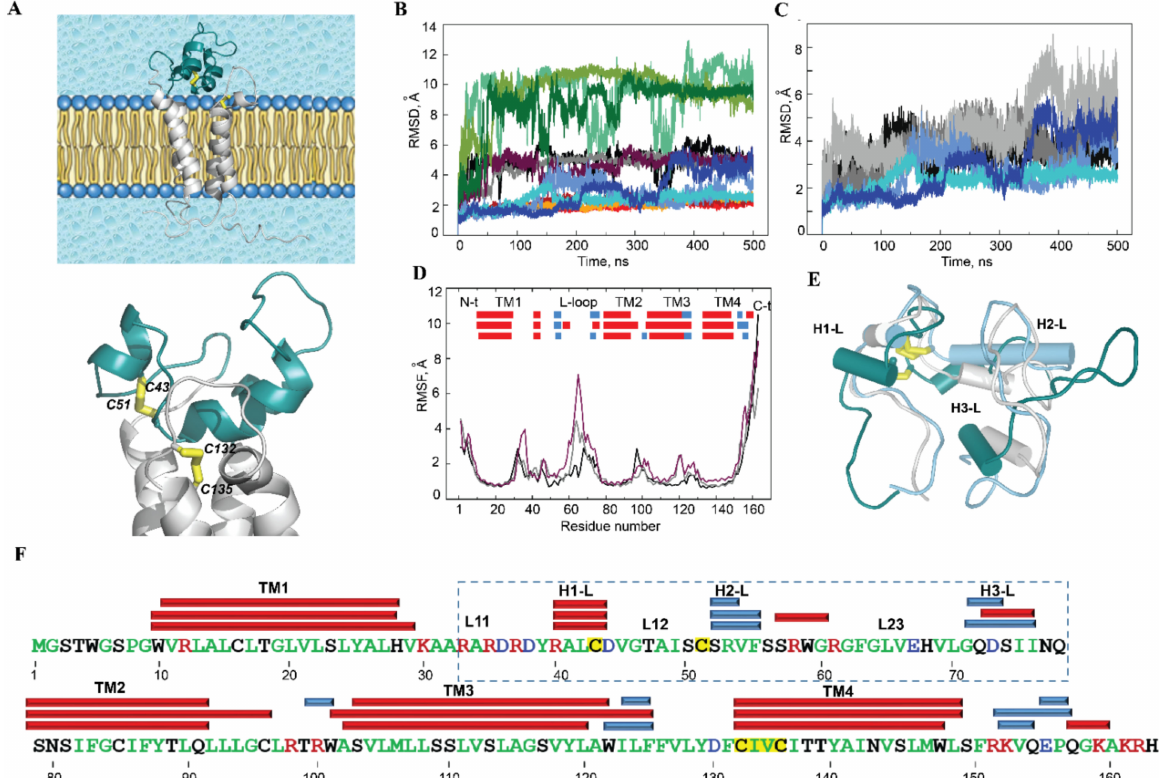
Figure 6. hVKORC1 in its inactive state and its conventional MD simulations. ( A ) 3D model of hVKORC1 in its inactive state; it was inserted into the membrane (top) and zoomed in on the L-loop (bottom). The L-loop is highlighted by the colour teal; disulphide bridges formed by cysteine residues C43-C51 and C132-C135 are drawn as yellow sticks. Transmembrane helices (TMs) are numbered as in [6]. ( B , C ) RMSDs computed for each MD trajectory (replicas 1–3 ) from initial coordinates (at t = 0 ns, the same for all replicas) on the C α -atoms of full-length hVKORC1 (in black, grey and rose brown), of the transmembrane domain (in orange, red and grenadine), of the L-loop (in clear aqua, bleu and navy) and of the N - and C -terminals (in teal, green and deep green) after fitting to the initial conformation of the respective fragment ( B ); of the L-loop (i) after fitting to its initial conformation (clear aqua, blue and navy blue) and (ii) after fitting of the protein coordinates to the initial conformation of the TMD (black, grey and silver) ( C ). ( D ) RMSFs computed for C α -atoms of the MD conformations (replicas 1 – 3 ) after fitting to the initial conformation (at t = 0 ns, the same for all replicas; in black, grey and rose brown). In the insert, the folded secondary structures, α H- (red) and 3 10 -helices (blue), were assigned for a mean conformation of each MD trajectory. ( E ) Superimposition of the L-loop conformations picked from replica 3 at 150 (grey), 250 (light blue) and 375 ns (deep teal). ( F ) The hVKORC1 sequence (Q9BQB6) and the secondary structure assignment for a mean conformation over each MD trajectory. Residues are coloured according to their properties: positively and negatively charged residues are in red and blue, respectively; hydrophobic residues are in green; polar and amphipathic residues are in black; residues C43, C51 and the CX 1 X 2 C motif are highlighted by a yellow background. α - and 3 10 -helices are shown as red and blue batons, respectively. Secondary structure labelling is shown above the VKORC1 sequence. The L-loop sequence is surrounded by dashed